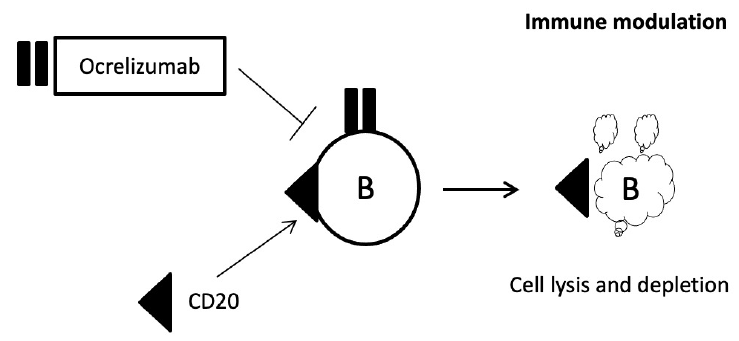
Figure 7. Mechanism of action of siponimod.